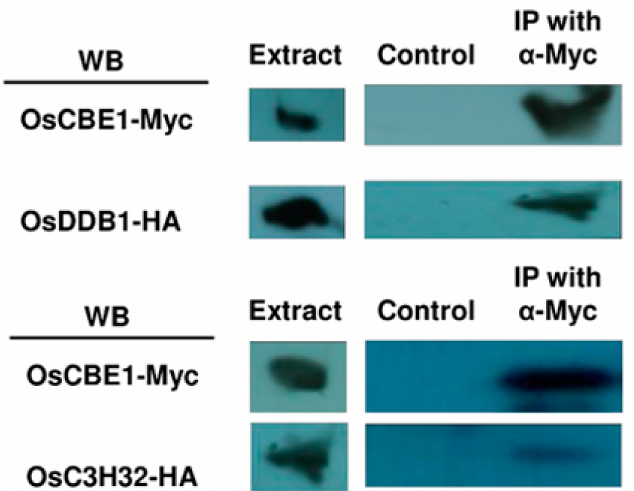
Figure 5. Co-IP with OsCBE1 and predicted substrate. To confirm whether the putative substrate from the in silico method can interact with OsCBE1, we performed Co-IP using transient expressed Myc tagged OsCBE1 and HA tagged predicted substrate in rice suspension